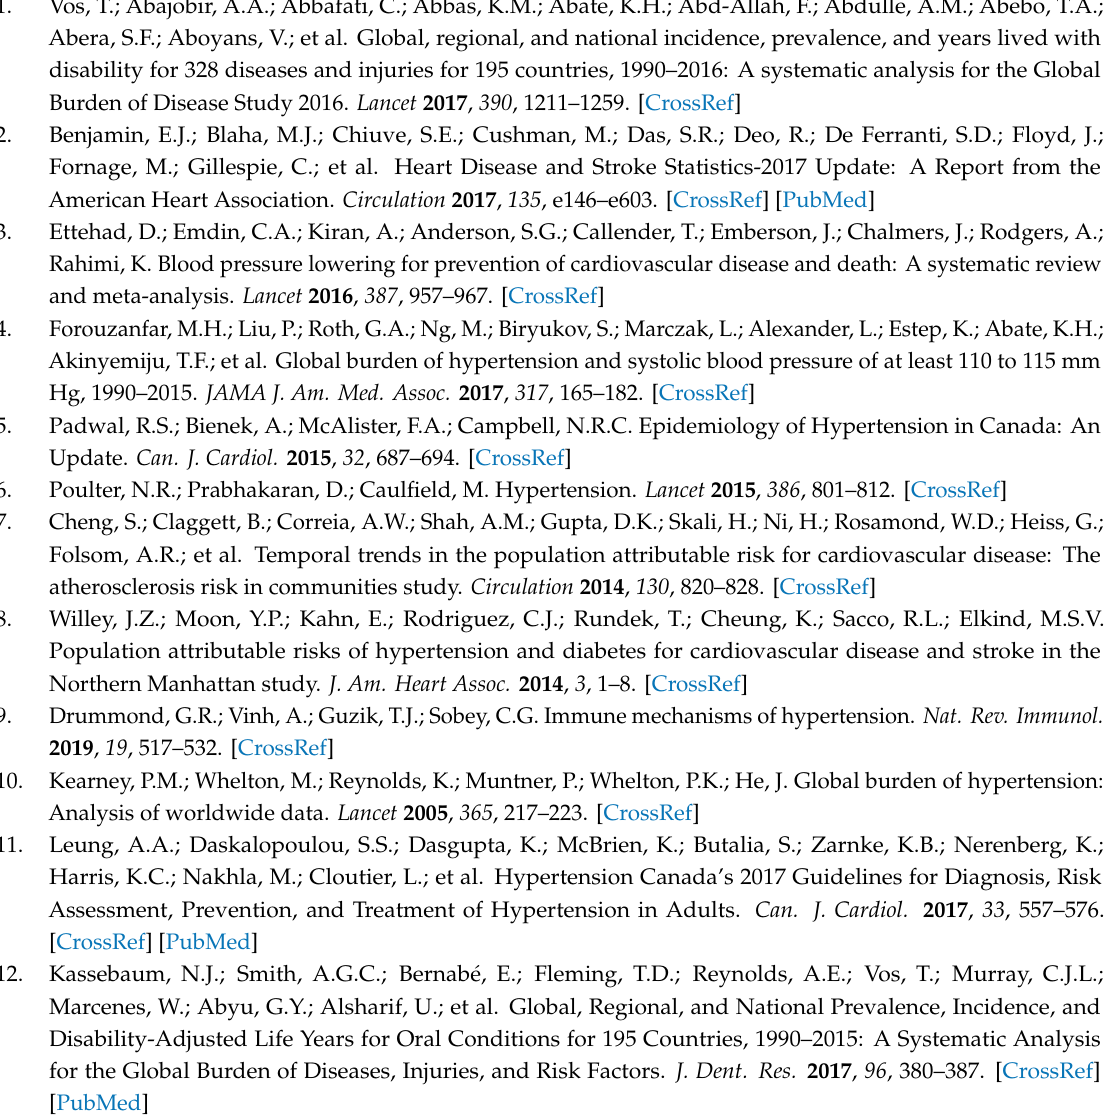
Figure S1: ROC Analysis using periodontal diagnosis, Figure S2: ROC Analysis using periodontal measures, Table S1: Comparison of baseline characteristics between healthy, gingivitis and periodontitis stages (N =